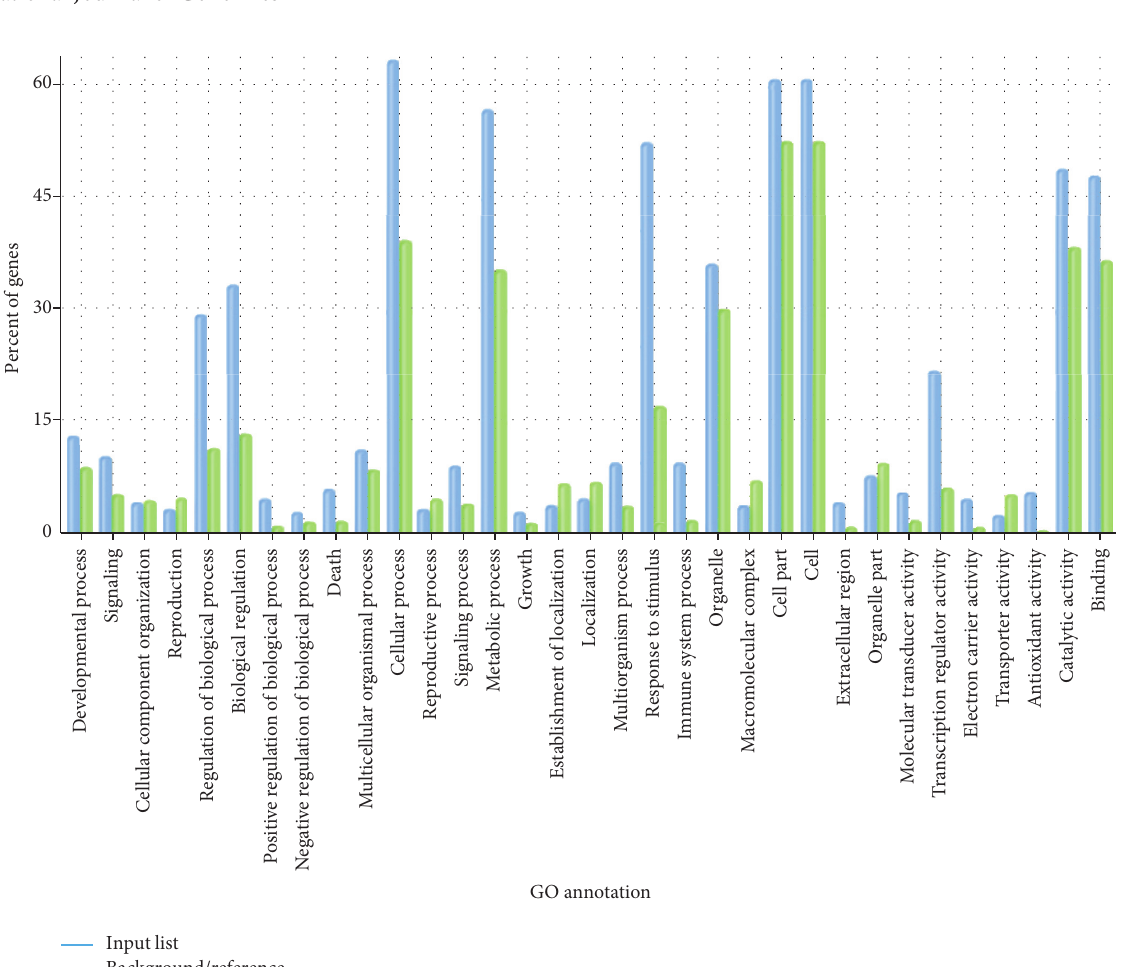
Figure 5: Flash bar chart of overrepresented terms in all three categories. The y -axis is the percentage of genes mapped by the term and represents the abundance of the GO term. The percentage for the input list is calculated by the number of genes mapped to the GO term divided by the total number of genes in the input list. The same calculation was applied to the reference list to generate its percentage. These two lists are represented using different colors. The 𝑥 -axis is the definition of the GO